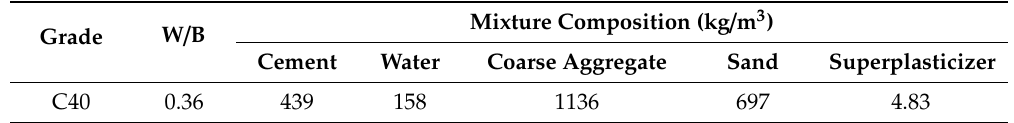
Table 1. Concrete mix proportion.